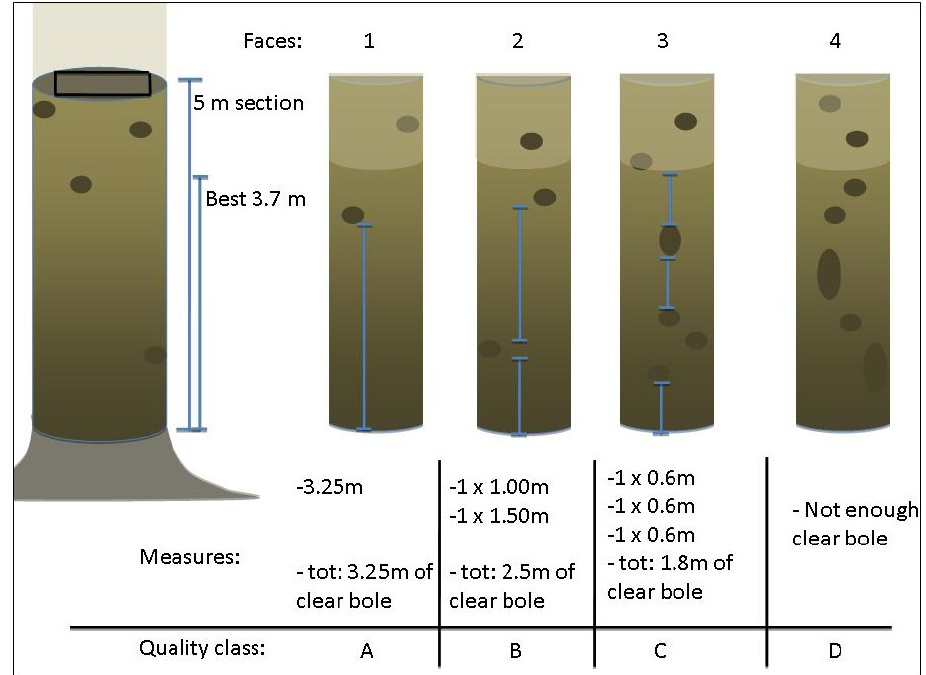
Figure 2. Example of standing hardwood tree classification as described by Monger [35]. The blue bars on each face represent the clear bole sections, which were used in our stem quality